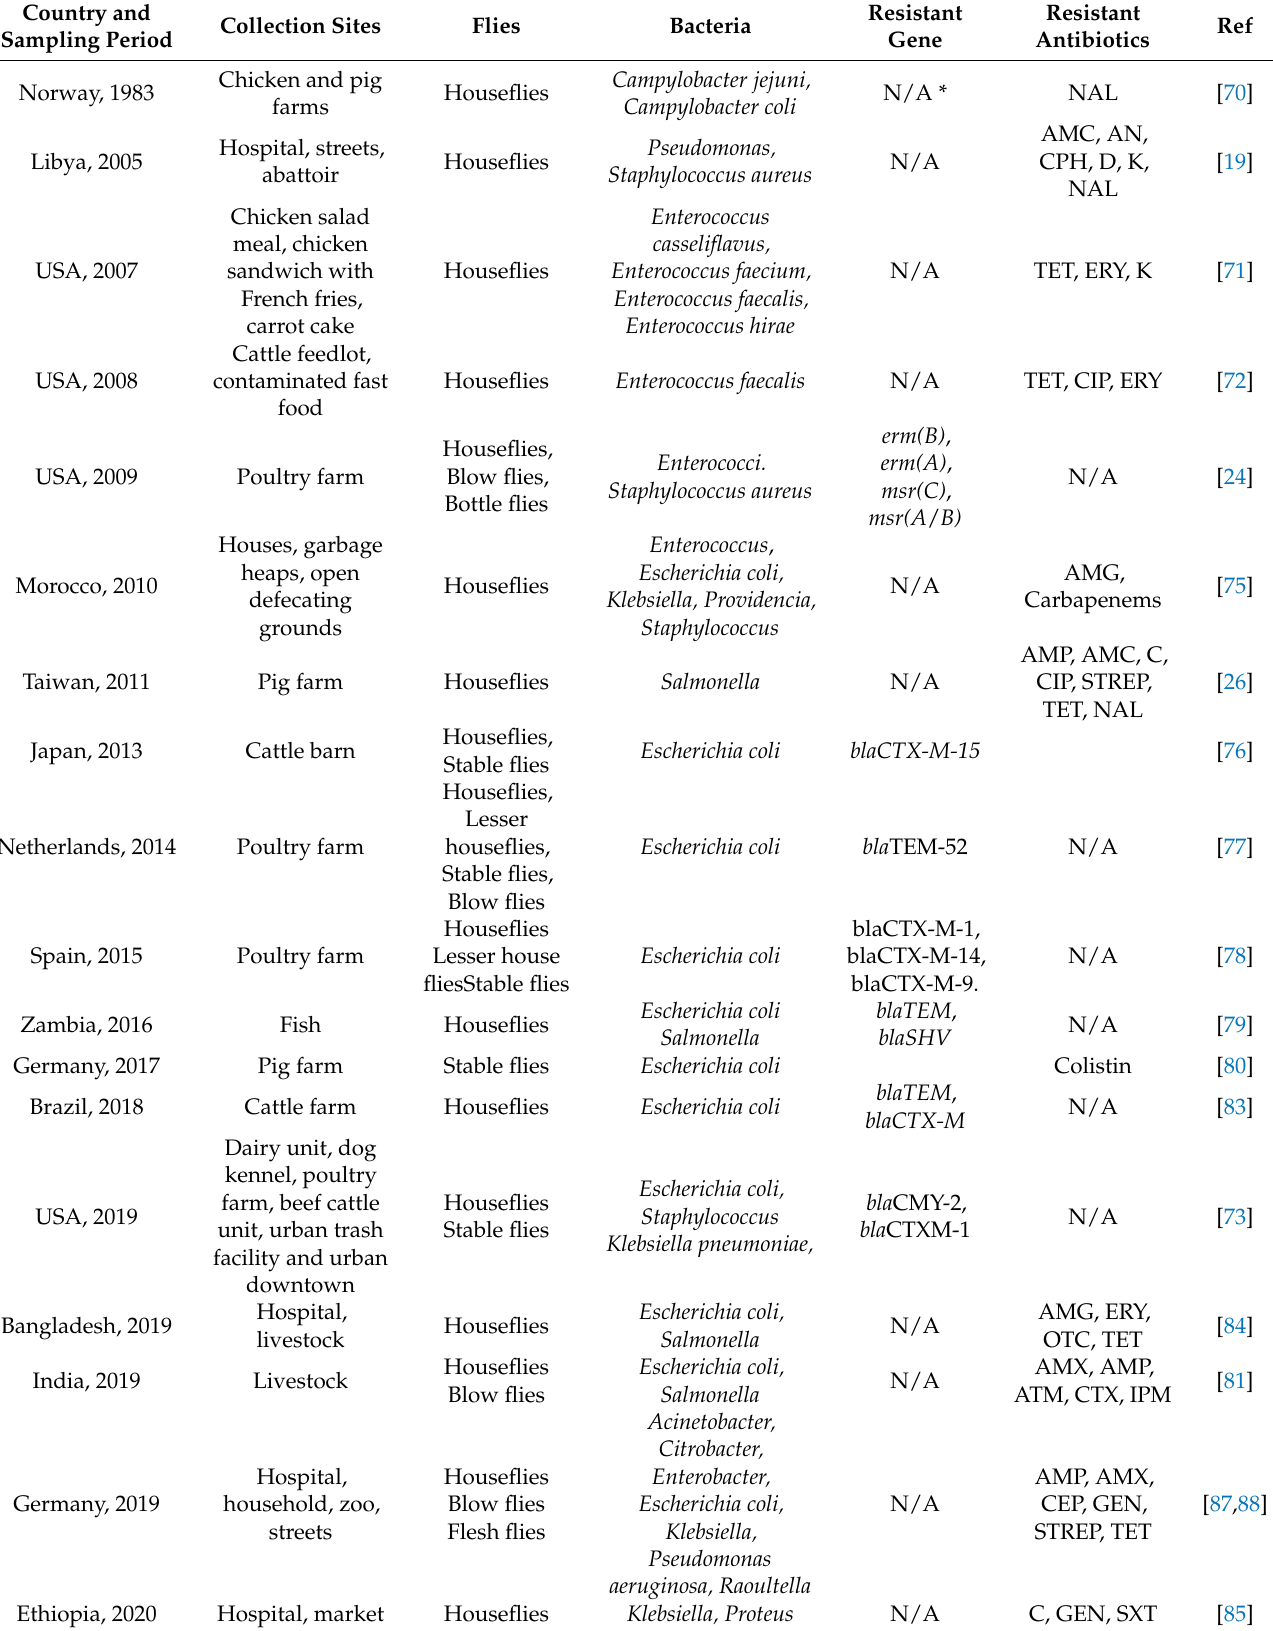
Table 1. Overview of multidrug antimicrobial resistance in